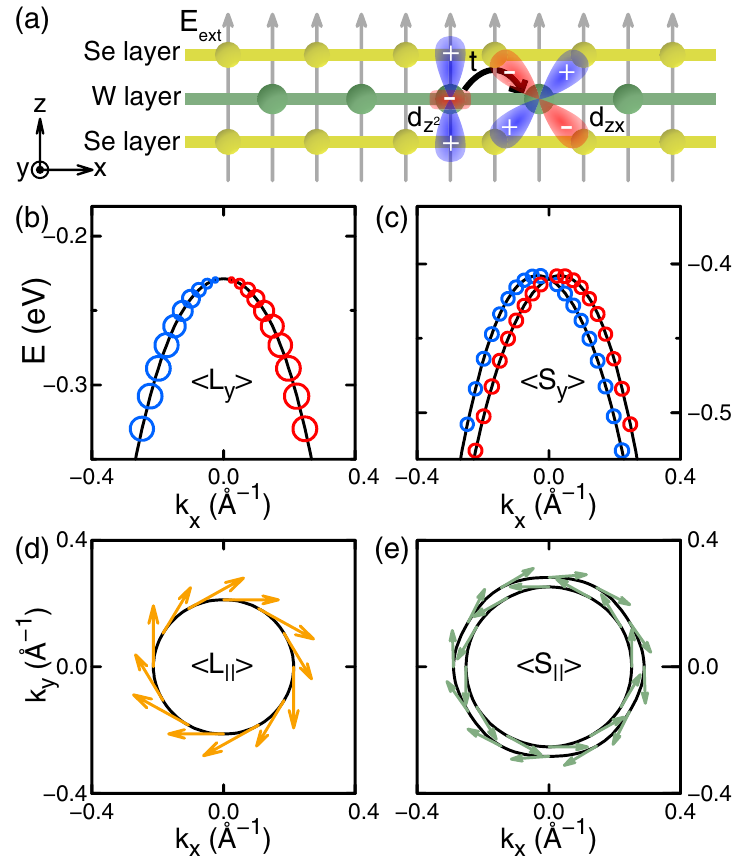
Figure 3. WSe 2 monolayer under external electric field E ext = 1 V/Å. ( a ) Schematic representation of the interatomic hopping between d and d zx orbitals of W atoms. ( b , c ) The highest valence band(s) near Γ z 2 obtained ( b ) without SOI and ( c ) with SOI, where 0 eV is the valence band maximum at K in each case. The size of open dots represents | 〈 L y 〉 | obtained without SOI in ( b ) and | 〈 S y 〉 | obtained with SOI in ( c ), with blue for positive and red for negative values. ( d , e ) Constant-energy cut of the highest valence band(s) near Γ obtained ( d ) without SOI at the energy of − 0.3 eV and ( e ) with SOI at − 0.5 eV. Arrows are in-plane components of OAM obtained without SOI in ( d ) and those of the spin obtained with SOI in ( e ). Although it is rather large to be applied, 1 V/Å is chosen for clear presentation. The spin splitting is found proportional to E ext in the range from 0 to 2